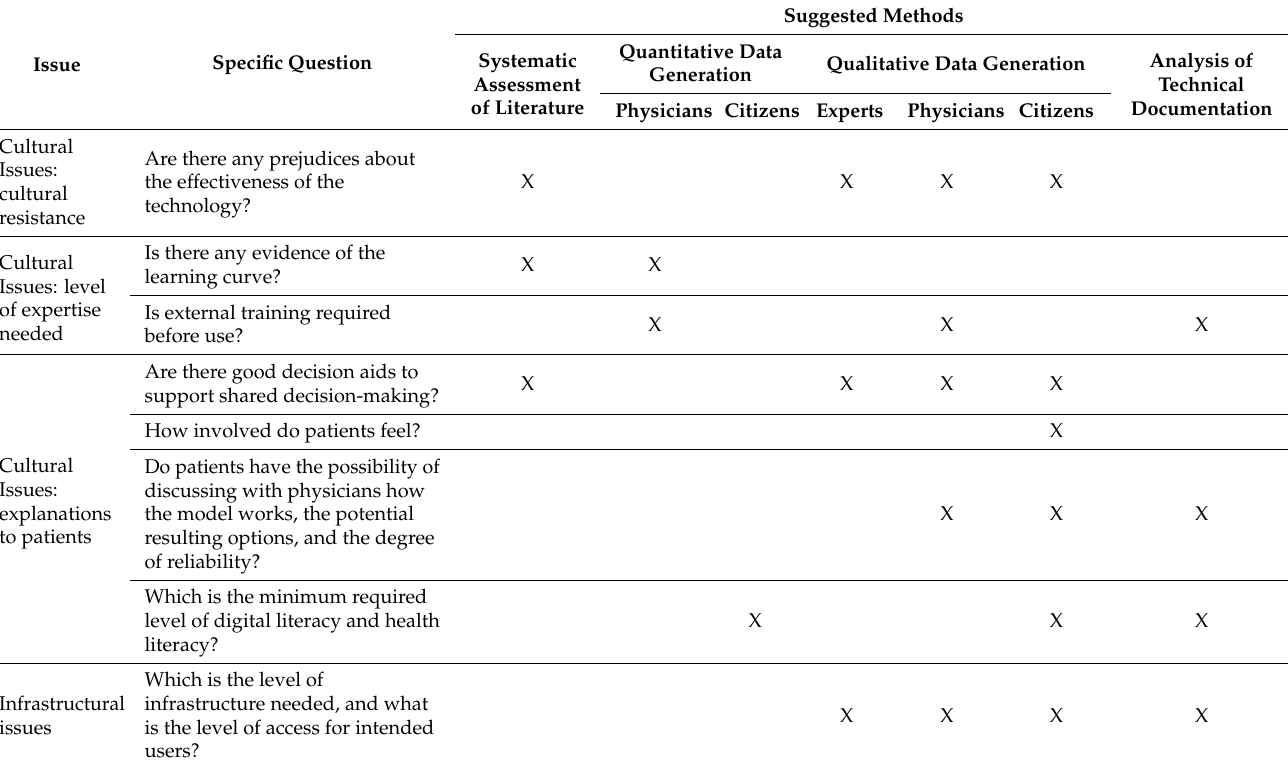
Table 1. Social domain: practical examples of questions and suggested